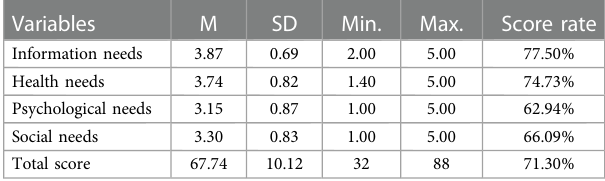
TABLE 3 Meanandstandarddeviationsofvariablesofnursingneeds( N =211). Variables